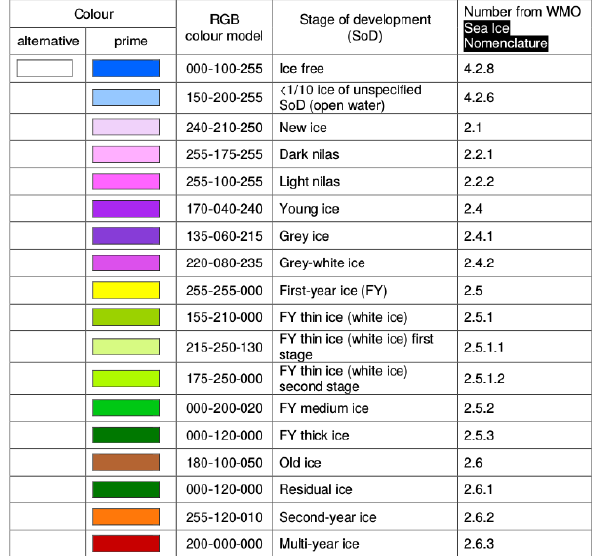
Table B1. Colour coding of the sea ice types in the ice charts shown